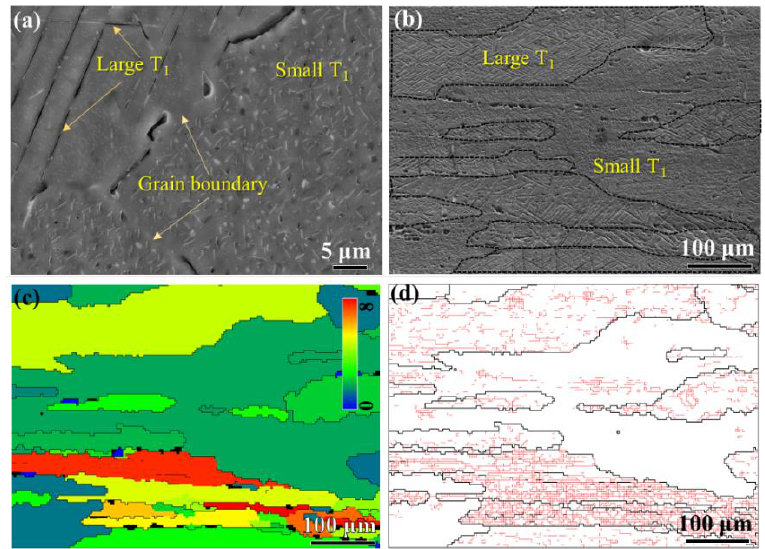
Figure 5. Correlation between the precipitation of T 1 phase and the local grain structure in 2A97 alloy that solution treated at 520 ◦ C for 1 h and cooled by FC: ( a ) SE image at high magnification; ( b ) SE image at low magnification; ( c ) GOS map and ( d ) GB map corresponding to ( b ).